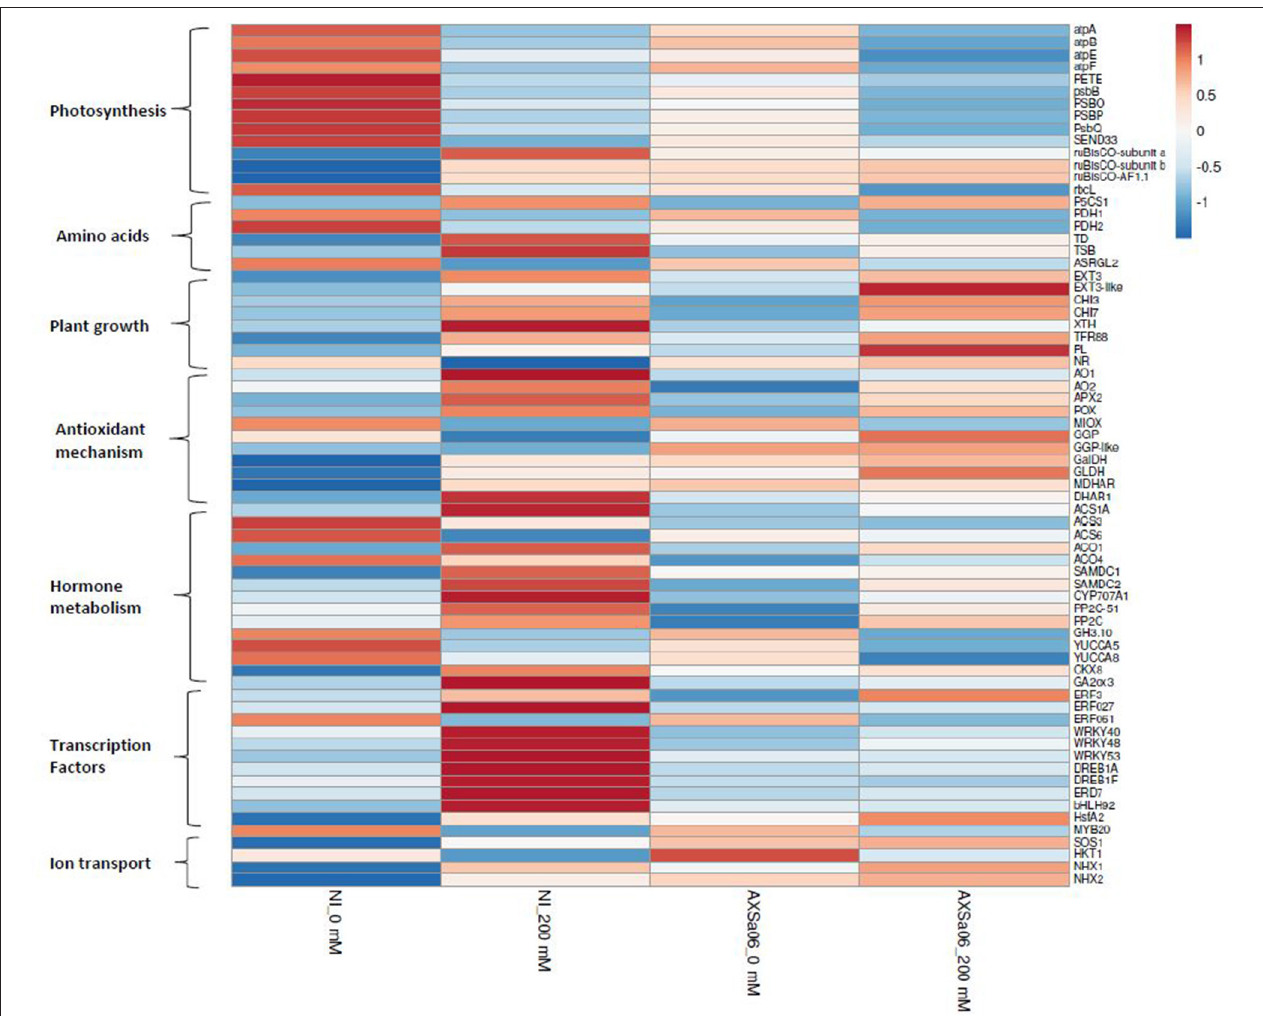
FIGURE 5 | Heatmap of selected genes of interest related to photosynthesis, amino acids, plant growth, antioxidant mechanism, hormone metabolism, transcription factors and ion transport, in the leaves of tomato seedlings inoculated with AXSa06 ( Pseudomonas oryzihabitans ) at exposure to 200mM NaCl, based on log 2 transformed FPKM values. The entire list of these genes followed by FPKM values is provided in Supplementary Table 10 . NI,